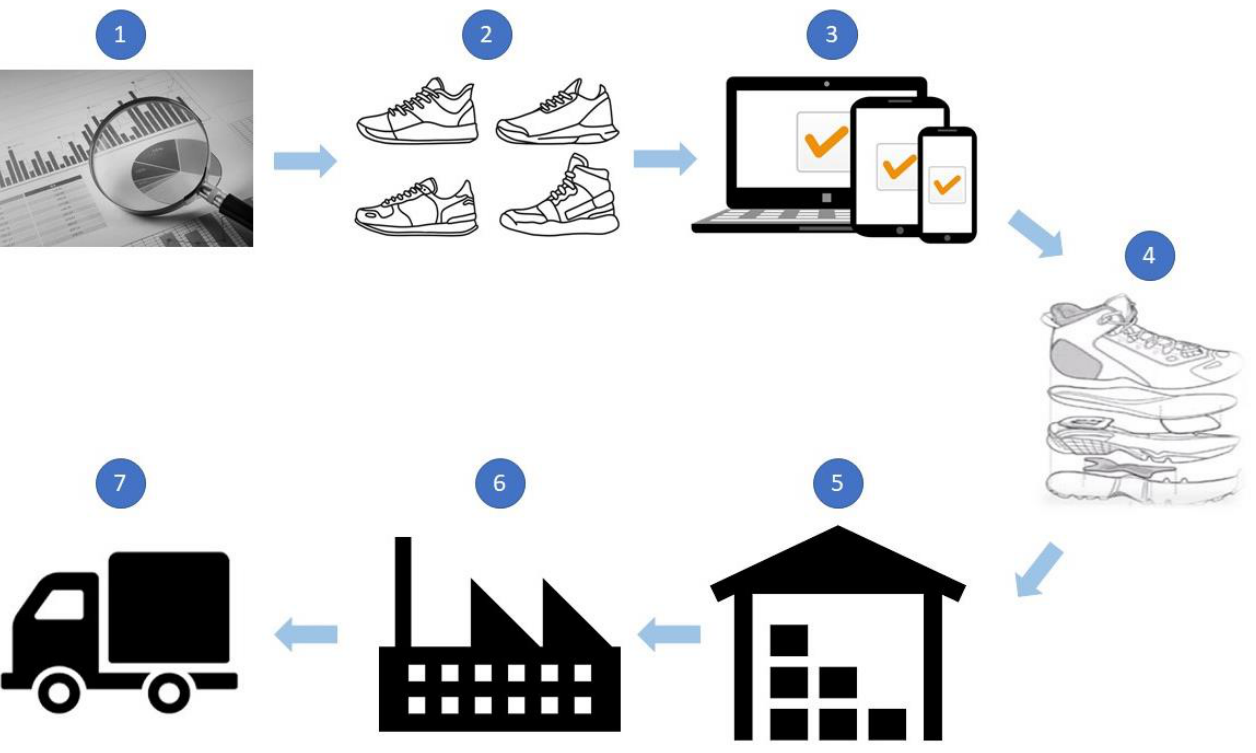
Figure 1. Shoe factory seasonal production cycle.